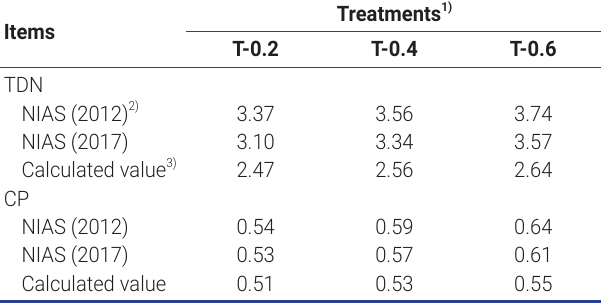
Calculated value 0.51